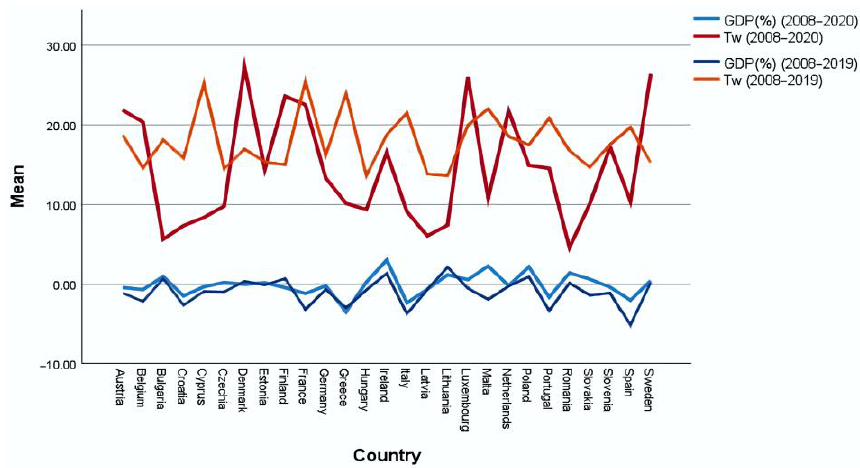
Figure 6. The mean values of economic growth and the teleworking ratio for the period 2008 – 2020.